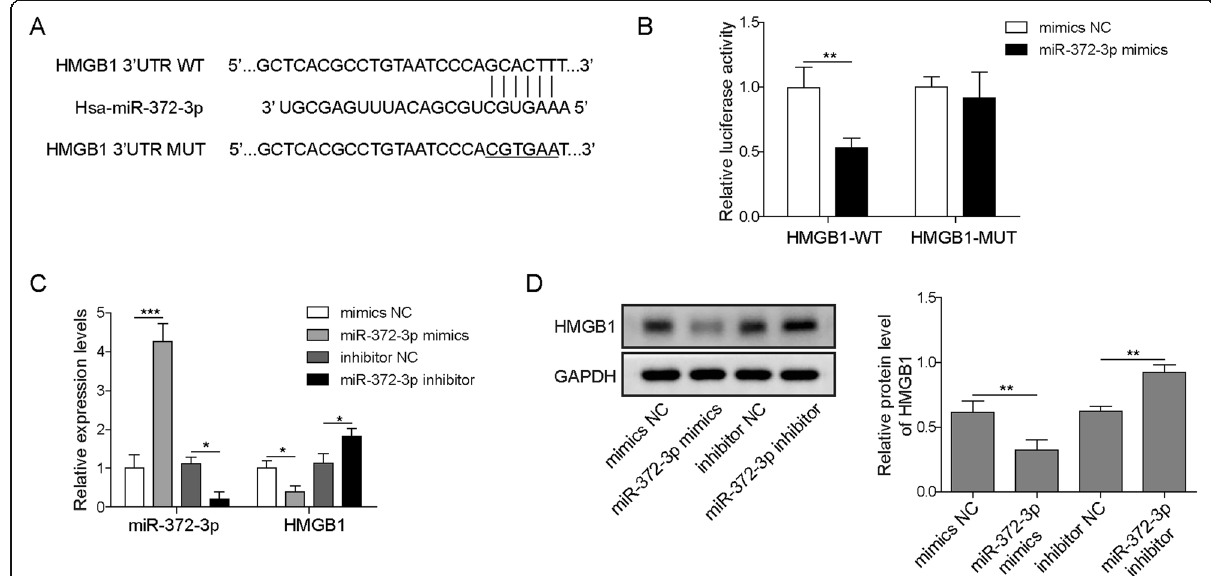
Fig. 5 HMGB1 was a direct target of miR-372-3p. The potential binding sites between miR-373 and HMGB1 were predicted (A). The miR-372-3p mimics and luciferase reporter plasmids with wild-type or mutant HMGB1 3 ′ -UTR were co-transfected into U2OS cells. A dual luciferase reporter assay was performed to verify the direct binding relationship between miR-372-3p and HMGB1 (B). U2OS cells were transfected with mimics NC, miR-372-3p mimics, inhibitor NC or miR-372-3p inhibitor, and then qRT-PCR was performed to evaluate the relative expression levels of miR-372- 3p and HMGB1 (C). The expression level of HMGB1 was analysed by western blot (D). Data are shown as the mean ± SD. * p < 0.05, ** p <